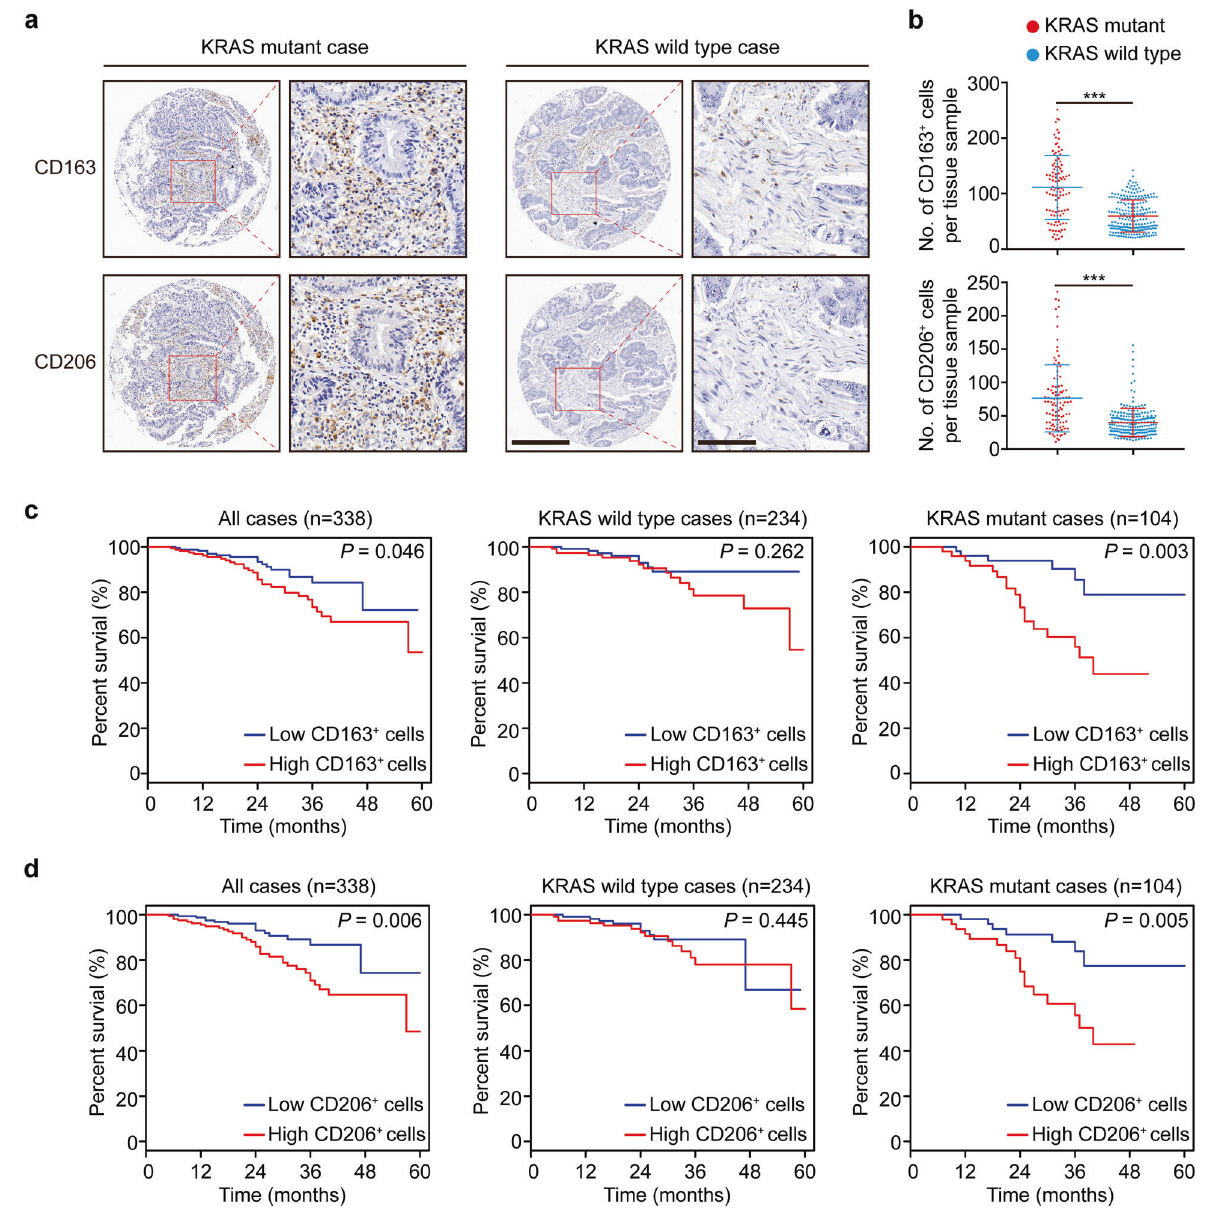
Fig. 1 KRAS mutation positively correlates with TAMs in CRC. a Immunostaining of CD163 and CD206 in the tumor stroma in a representative human CRC case carrying mutant KRAS compared to a KRAS wild-type case. Scale bars: 400 μ m (left), 100 μ m (right). b Quanti fi cation of CD163 + and CD206 + macrophages in all 338 human CRC samples. c , d Kaplan – Meier survival curve of CRC patients layered by the density of CD163 + or CD206 + macrophages within the tumor stroma in tissue microarrays. *** p ≤ 0.001, by two-tailed Student ’ s t -test ( b ) or log-rank